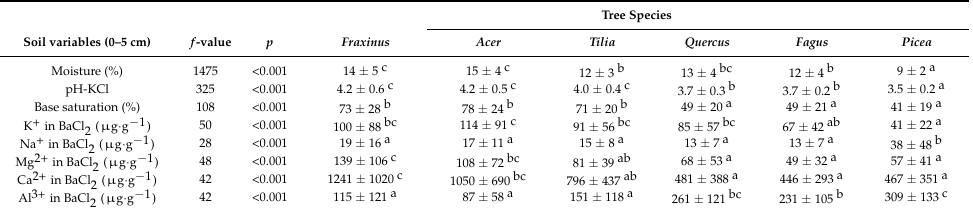
Table 1. Mean and standard deviation of topsoil (0–5 cm) properties for each tree species across all six common gardens. Significant differences between tree species are indicated with letters, means with the same letter are not significantly different (Tukey post-hoc tests on linear mixed-effects (LME) models,